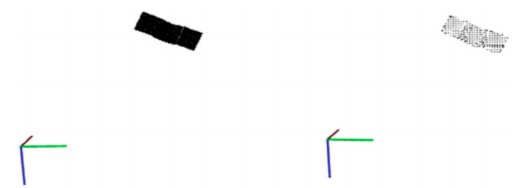
Figure 5. The example of the point cloud simplification ( left : the dense point cloud data; right : the result of the simplification